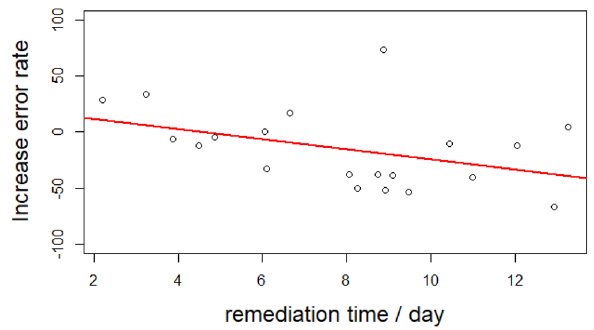
Figure 6. Significant correlation between the time spent per day training visual search on symbols and the decrease in error rate between the pre- and post-training